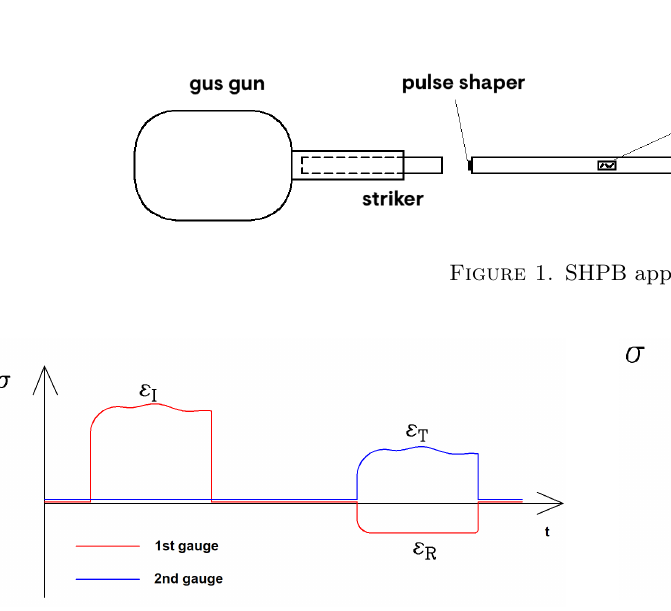
Figure 4. Original and shaped